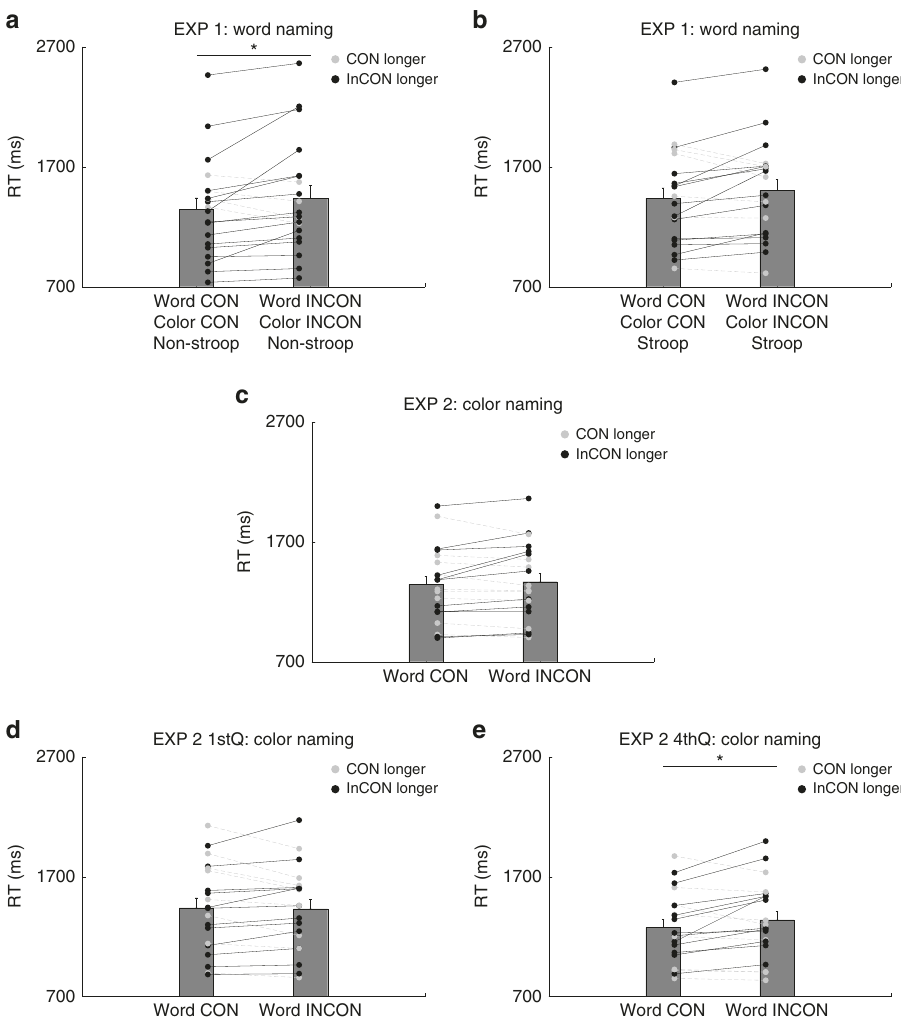
Fig. 2 Experiments 1 and 2 results. n = 20 in each experiment. Y -axis denotes reaction time, and X -axis denotes congruent and incongruent conditions between the subliminal prime and supraliminal target (CON: congruent; INCON: incongruent; Non-Stroop/Stroop denotes whether target word was a Non- Stroop or Stroop word). A/B, a three- way interaction among word/color congruency and target Stroop, showing double incongruency slowed down responses only when target was not a Stroop word. C~E, reaction time of word congruent and incongruent conditions in all trials (C), 1st quarter trials (D), and the 4th quarter trials (E) in Experiment 2. Black dots and lines denote longer RT in the incongruent condition while gray dots and lines denote longer RT in the congruent condition. Each pair of dots represents one participant. The bars denote group mean with the error bars indicating standard error of the mean (SEM). Asterisk denotes signi fi cance (A: Exp 1: p = 0.02 (post hoc 2-tailed paired t test); E: Exp 2 4th quarter trials: p = 0.04 (a main effect in a three-way (word-color congruent)). In this article, we refer to prime-target color congruency as color congruency, prime-target word con- gruency as word congruency, and target word-color congruency as target Stroop/Non-Stroop throughout the manuscript. A three-way repeated measures analysis of variance was performed on the target